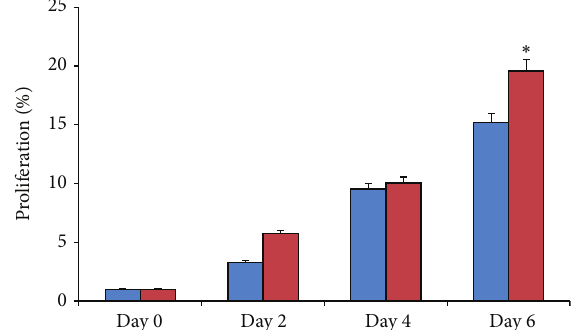
Figure 2: EGE cell proliferation with and without SW872 coculture. EGE cells were cocultured with SW872 cells for days 2, 4, and 6. Comparison in cell proliferation is made with EGE cells grown without SW872 coculture. Proliferation in EGE cells was measured using CyQuant assay. Results are expressed as means ± SE from 3 separate experiments. ∗ Significantly different from the control ( 𝑃 < 0.05